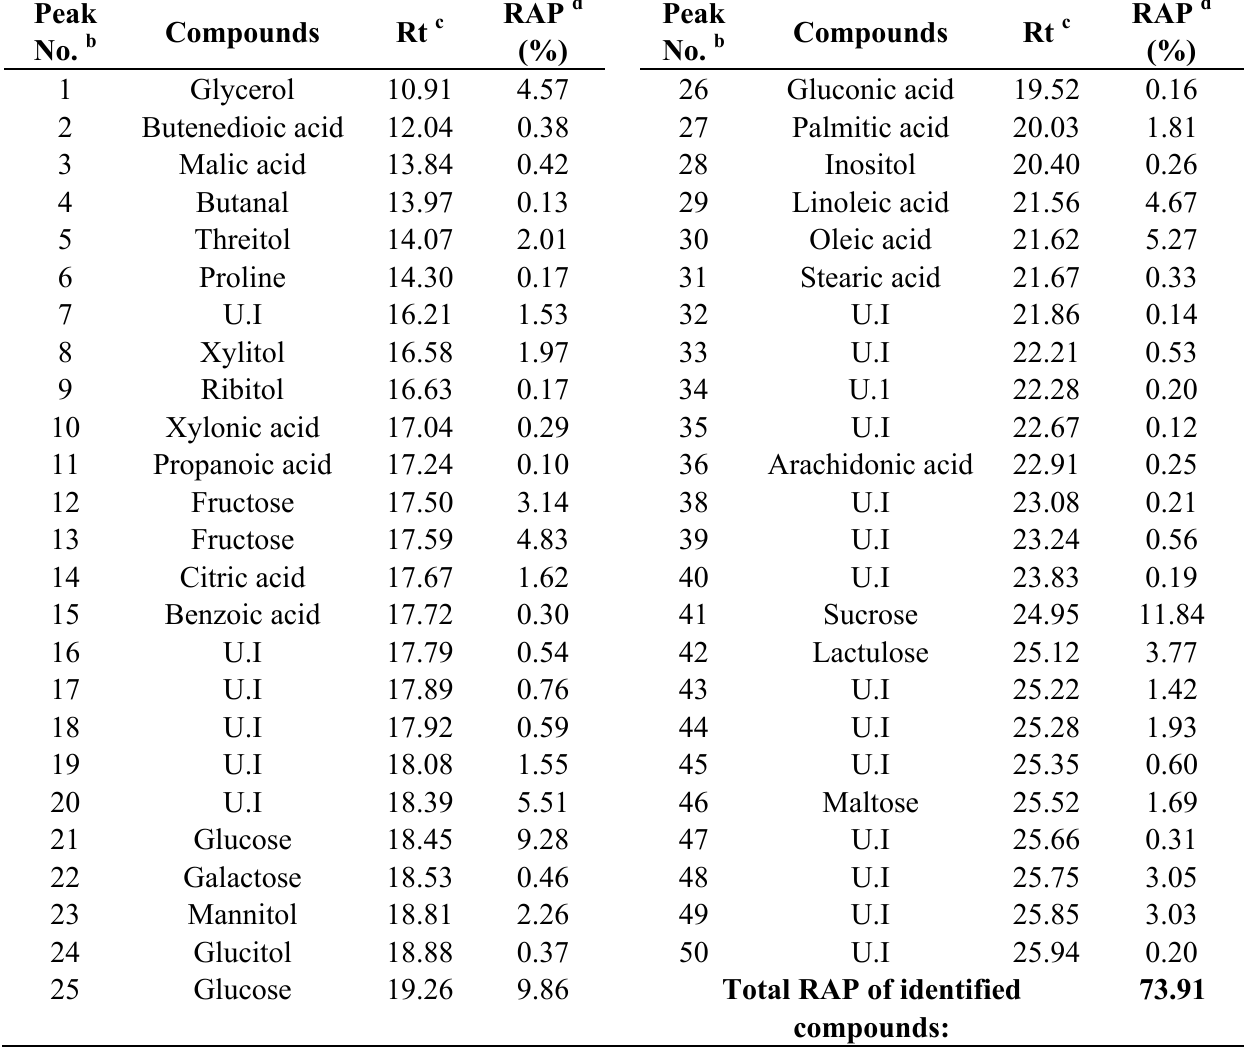
Table 1. Chemical composition of derivertised methanol extract a of Dryopteris crassirhizoma